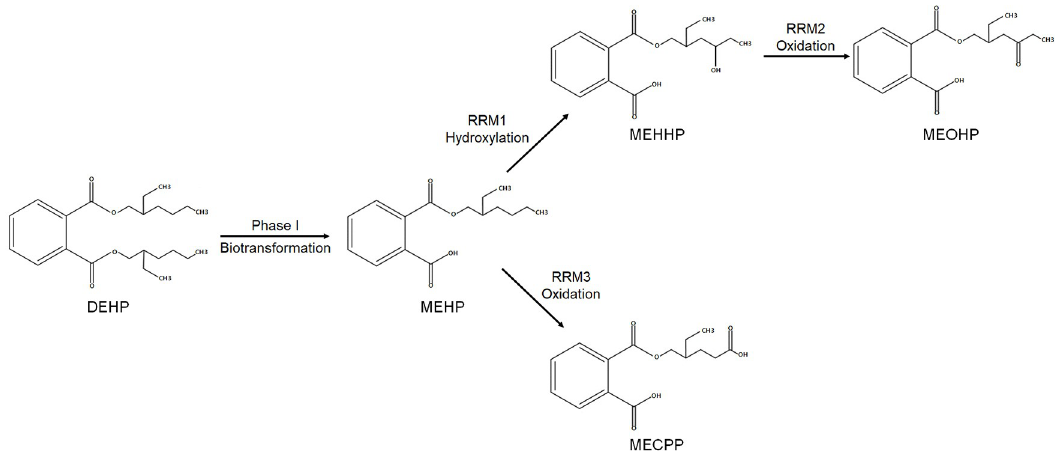
Fig 1. Metabolic pathway of di(2-ethylhexyl) phthalate (DEHP) metabolites. The relative rate of metabolism (RRM) was calculated as the product-to-precursor molar concentration ratio as follows: RRM1 = ([MEHHP] + [MEOHP])/[MEHP]; RRM2